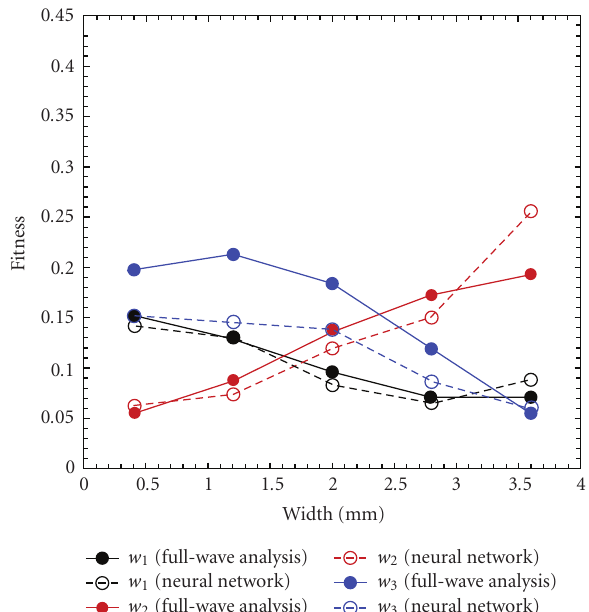
Figure 6: Dependences of the fitness value on the width of the metallic patches. The fitness values are obtained using the full-wave analysis (solid line) and the NN (dash line).